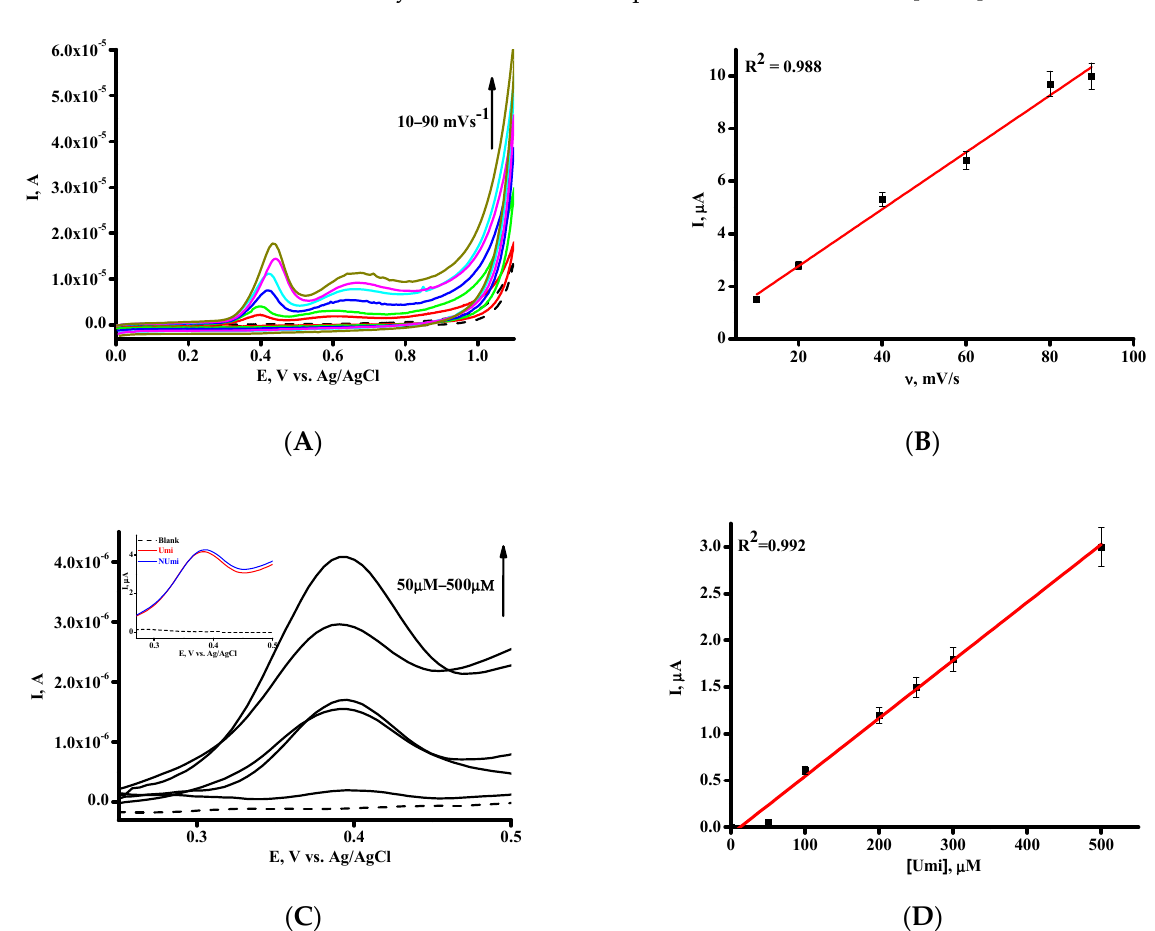
Figure 1. ( A ) CV of 500 µM Umi on SPE/SWCNT at different scan rates from 10 to 90 mV/s; ( B ) The plot of the oxidation peak current vs. the scan rate; ( C ) DP voltammograms recorded in PBS (pH 7.4) with increasing Umi concentration in the range of 50–500 µM. Dashed black line represents DPV of SPE/SWCNT in supporting electrolyte. The relative standard deviation of the DPV response on the SPE/SWCNT for three experiments was ±5%; Inset: DPV of 500 µM Umi and NUmi; ( D ) DPV peak current versus the concentration of Umi.